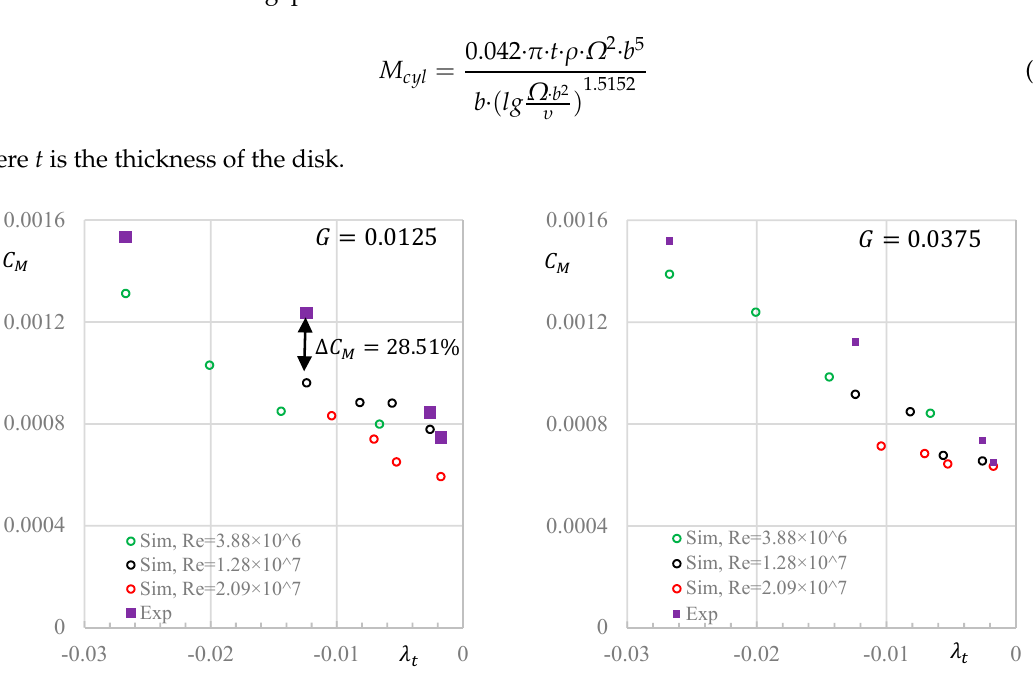
Figure 7. Variations of C M versus λ t for G = 0.0125 and G = 0.0375. Sim: from numerical simulations; Exp: by measurements.